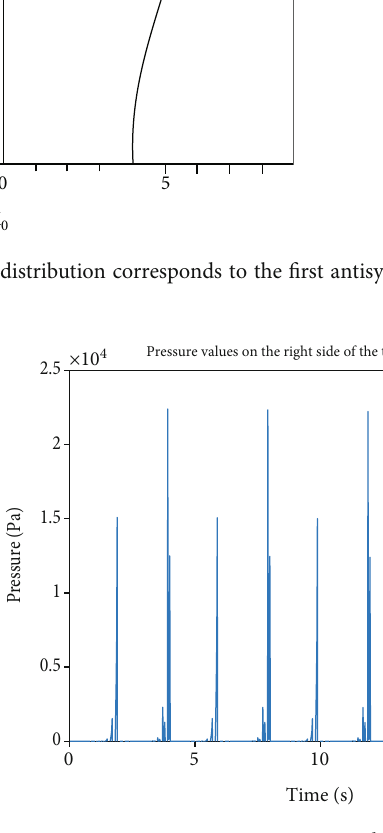
Figure 3: Variation in pressure acting on the tank wall for h = 0 : 18